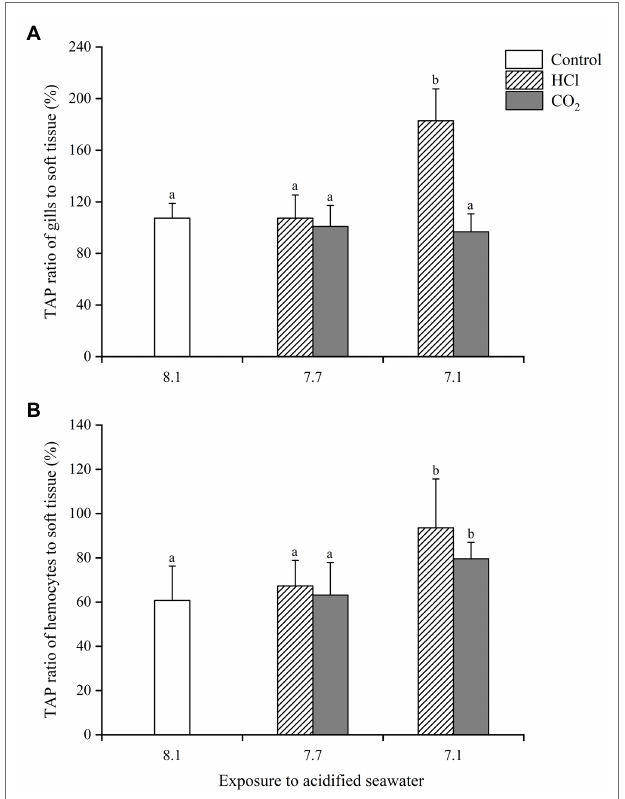
FIGURE 4 | Changes of energy allocation in gills (A) and hemocytes (B) of M. edulis under seawater acidification induced by HCl addition and CO 2 enrichment. Data were expressed as means ± SD ( n = 6). Different letters represent significant differences among experimental groups ( p <